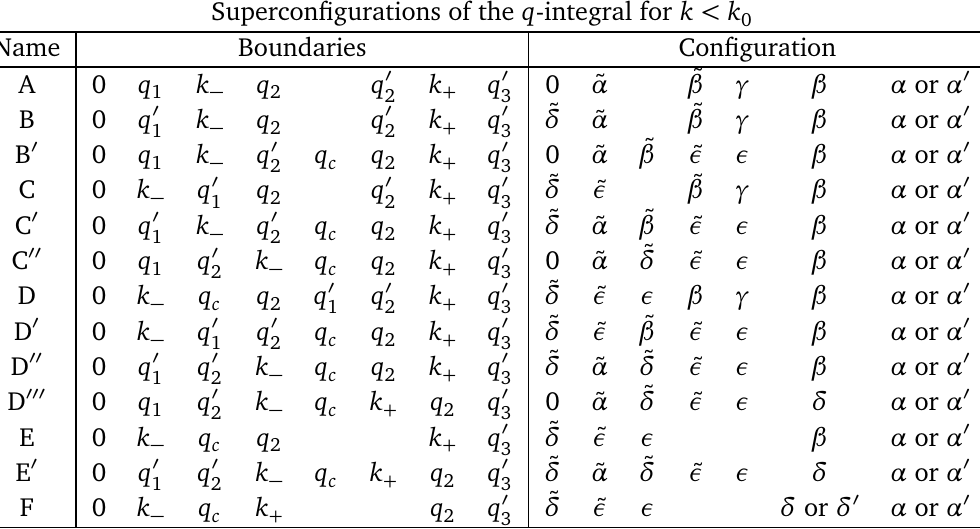
Table 2: For k < k , table of the resonance superconfigurations for the integration 0 over q (at fixed k and z and after integration over u and ω ). The first column k q is the name of the configuration in Roman letters, the second column is the list of p + 1 boundaries values of q (see Table 4 for their meaning) splitting the integration interval [ 0, + ∞ [ into p domains, and the third column is the configuration itself: a list of p greek letters (plus the final configuration 0 not written explicitly), each one denoting the shape of the resonance in the subintegral over ω (see Table q